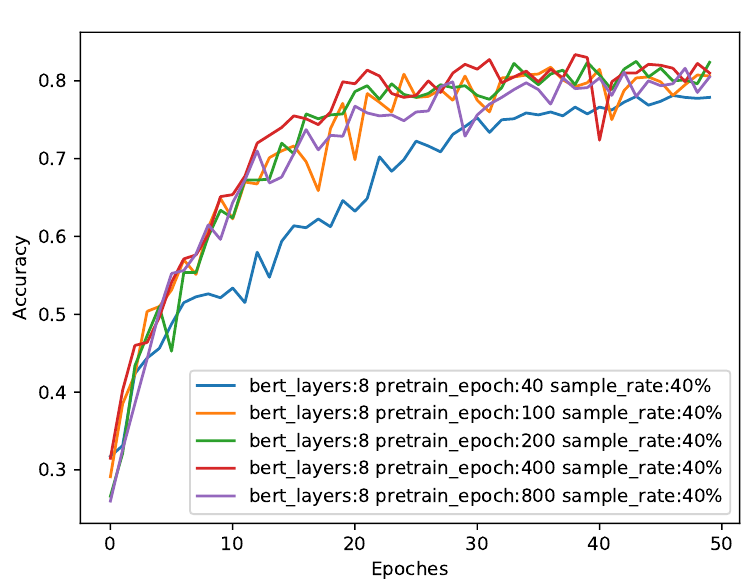
Figure 7. The impact of different pre-training epochs on accuracy when sample size is 0.4. The abscissa is the number of epochs during training in the downstream task, and the ordinate is the classification accuracy of the test. The four colors represent the performance of the eight-layer BERT in different epochs during pre-training.